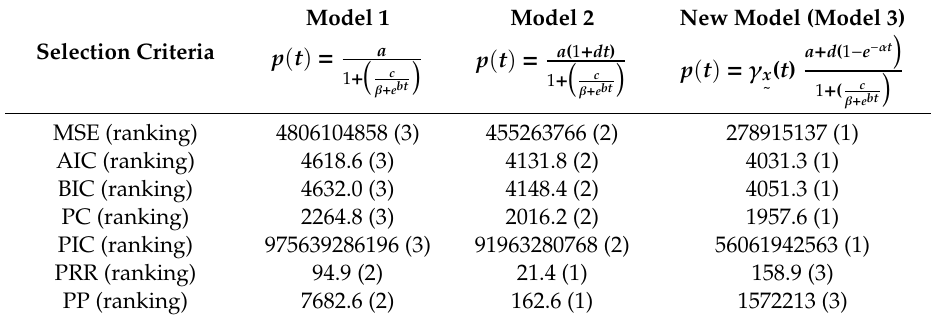
Table 3. Model comparison and ranking results using model selection criteria based on the available worldwide data.